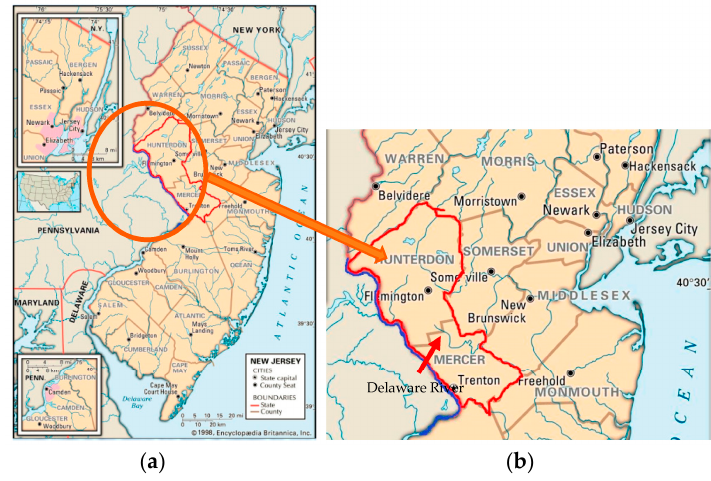
Figure 1. Site Map: ( a ) Full scale map of New Jersey (NJ) county boundaries with red highlighted study area; ( b ) Zoomed image with highlighted boundary for Hunterdon and Mercer counties and adjoining stretch of the Delaware River. Source: WordPress [12].